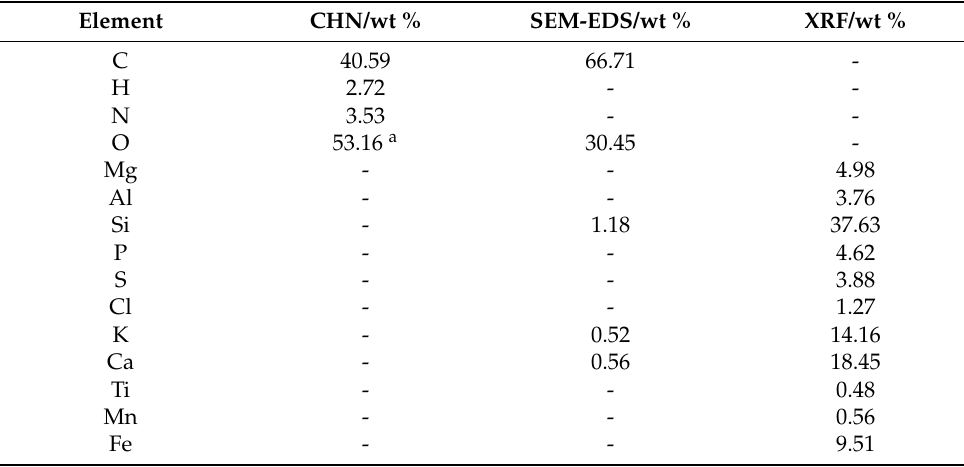
Table 1. Elemental analyses of BCR measured by CHN analyzer, SEM-EDS and XRF.